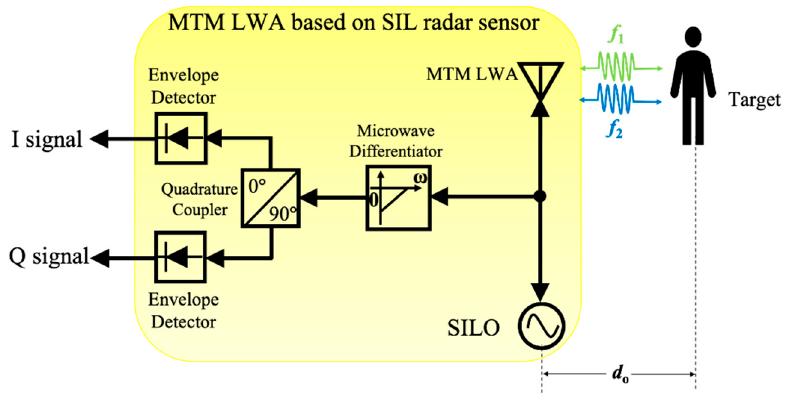
Figure 19. Frequency-shift keying (FSK) modulated SIL radar sensor for concurrent vital sign detection and location tracking of multiple targets.